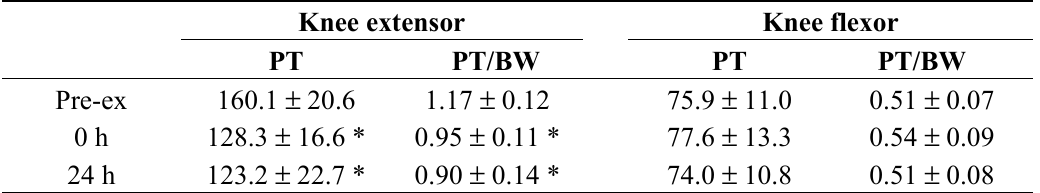
Table 1. Mean ± SD of peak torque (PT, ft-lb) and peak torque/body weight (PT/BW, ft-lb/lb) of knee extensor and knee flexor at 60° s − 1 of all subjects (n = 8) before (Pre-ex) and immediately (0 h), twenty-four (24 h) hours after exercise are shown.